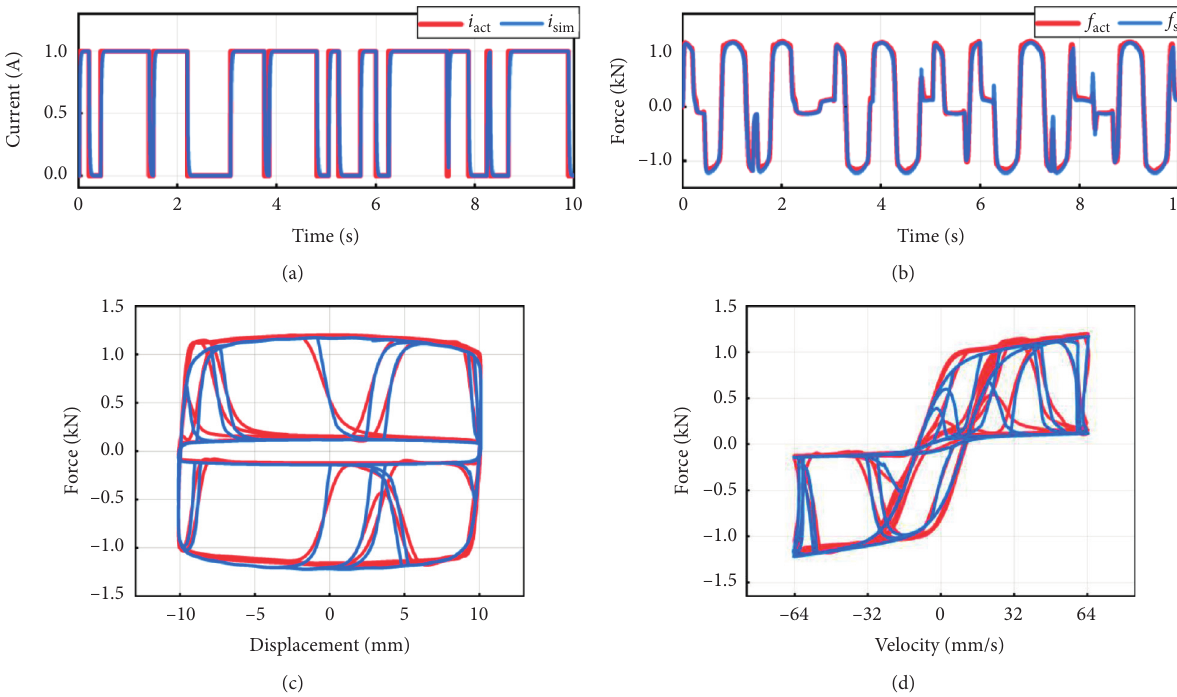
Figure 6: Comparison results for random step current input. (a) Step current. (b) Comparison of historical force. (c) Force versus velocity. (d) Force versus